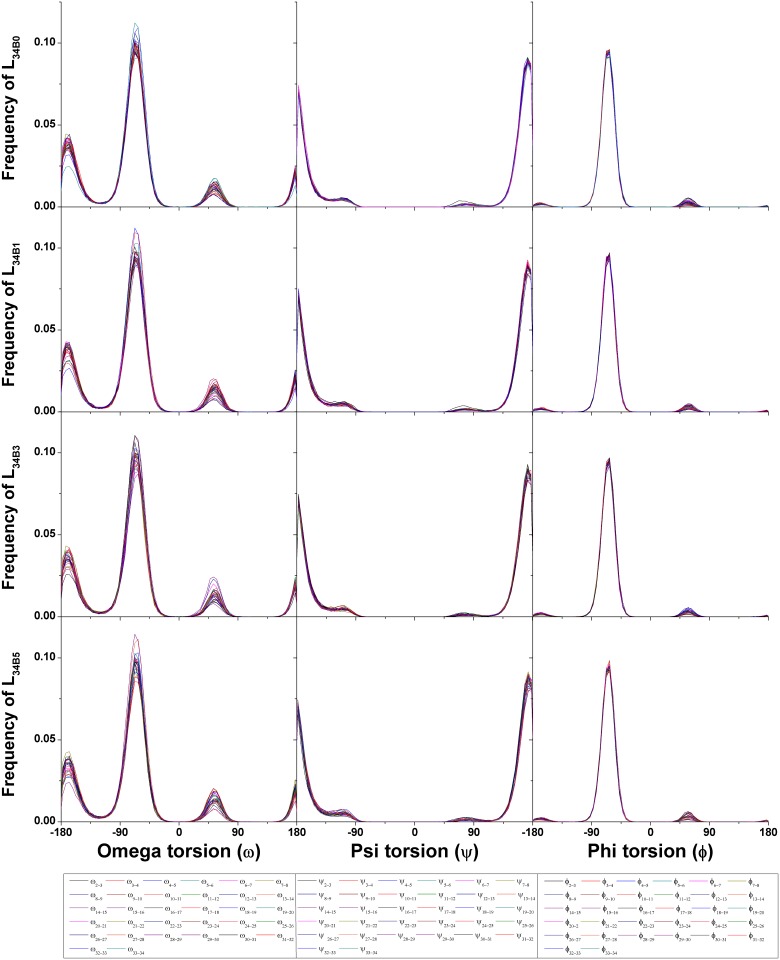
The occurrence frequencies of ω, ψ and ϕ between every two fructosyl residues of LFO34B0, LFO34B1, LFO34B3 and LFO34B5 simulated in the GBHCT model.Each dihedral angle is shown in different color.